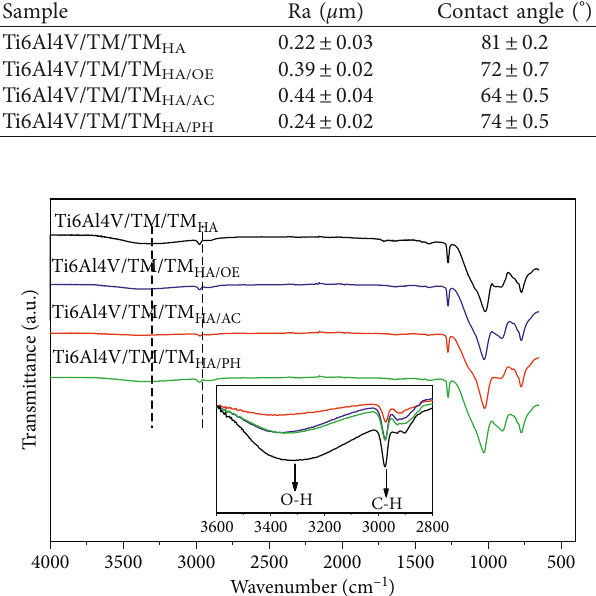
Figure 5: FTIR of the nonsterilized and the sterilized (by three different processes) hybrid coatings.